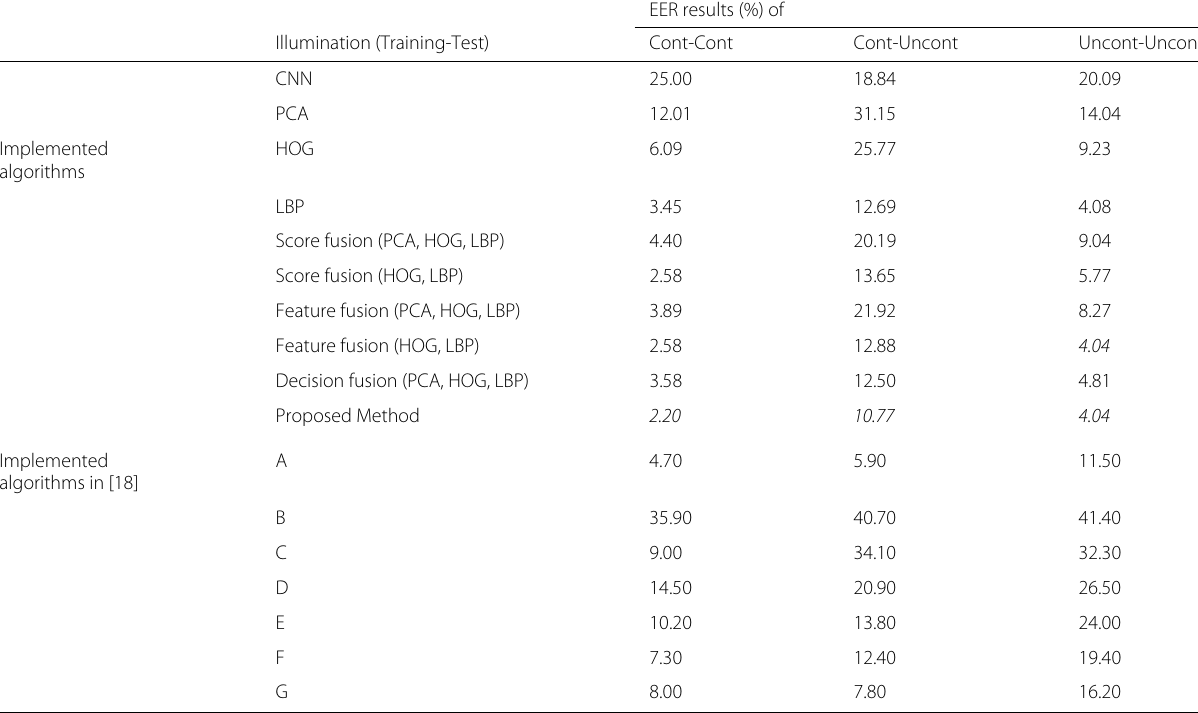
Table 4 EER results of illumination-based experiments for identical twins ( Cont controlled condition, Uncont uncontrolled condition)